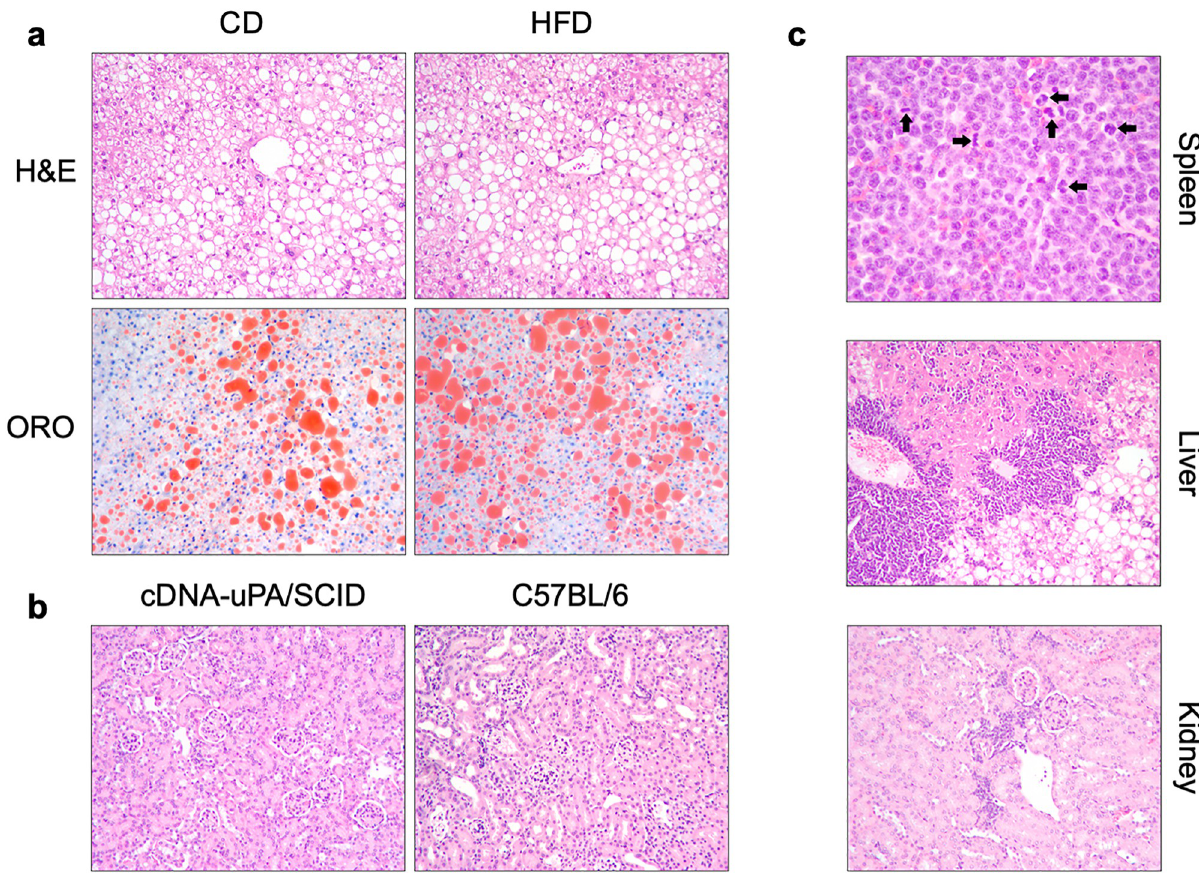
Fig 4. Liver and kidney histology in cDNA-uPA/SCID mice. (a) cDNA-uPA/SCID mice fed a HFD or a CD develop hepatic steatosis regardless of diet. Similar amounts of lipid droplets were observed in the ORO staining. (b) Kidney abnormalities in cDNA-uPA/SCID mice. Glomeruli in kidneys of cDNA-uPA/SCID mice showed an increase in the mesangial matrix with narrowing of the capillary loops, and variable increase in size, as compared to C57BL/6 mice. Hematoxylin eosin, 100x; Oil Red O, 100x. (c) Lymphoma in cDNA-uPA/SCID mice. The normal splenic architecture is effaced by an infiltrate of medium sized, hyperchromatic, monotonous cells with a high nuclear-cytoplasmic ratio and scant cytoplasm. The nuclei displayed irregular and coarse membranes, and contained clumped chromation with inconspicious nucleoli. Numerous mitotic figures (arrows) are present (top). The liver (middle) is massively involved and the kidney (bottom) shows a similar infiltrate of monotonous, dyscohesive, hyperchromatic